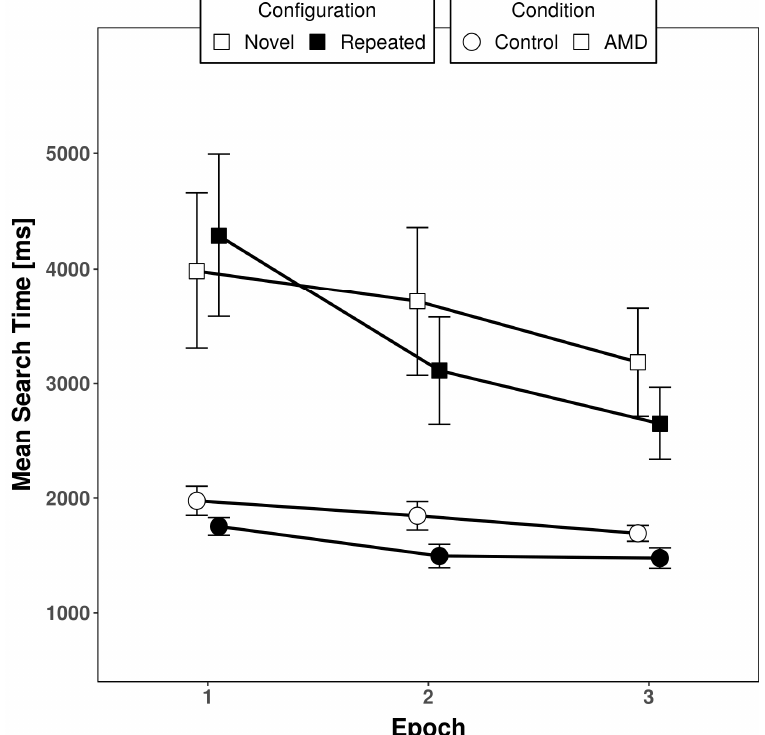
Figure 3. Averaged response times for controls (circles) and age-related macular degeneration (AMD) patients (squares) as a function of repeated (filled symbols) and novel (open symbols) search displays. Error bars depict the standard error of the mean.